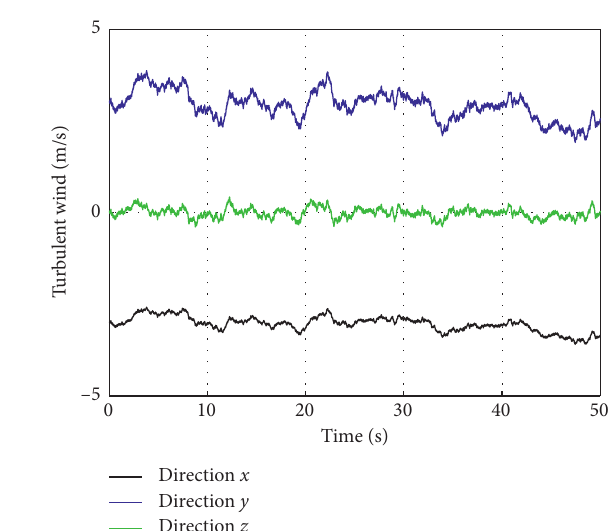
Figure 13: Turbulent flow field.